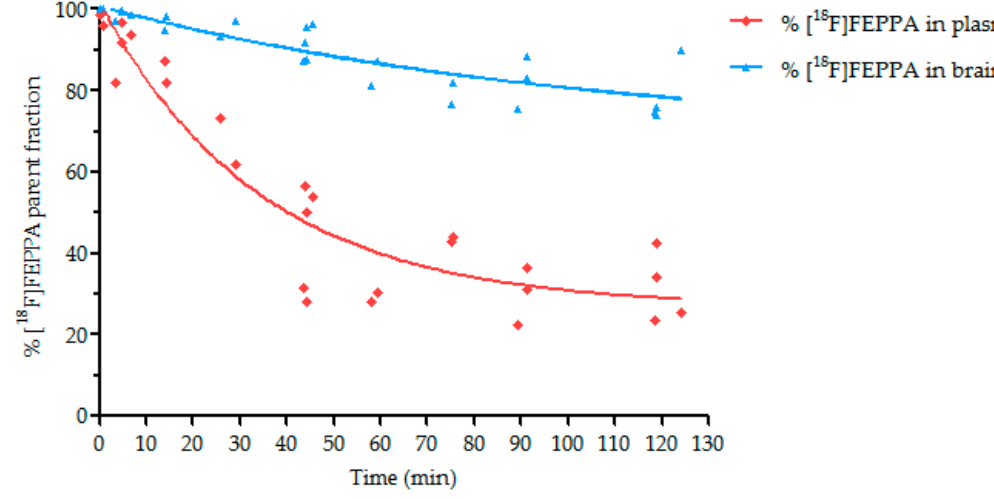
Figure 6. Percentage of parent fraction (unmetabolized) of [ 18 F]FEPPA in plasma and brain for control condition.